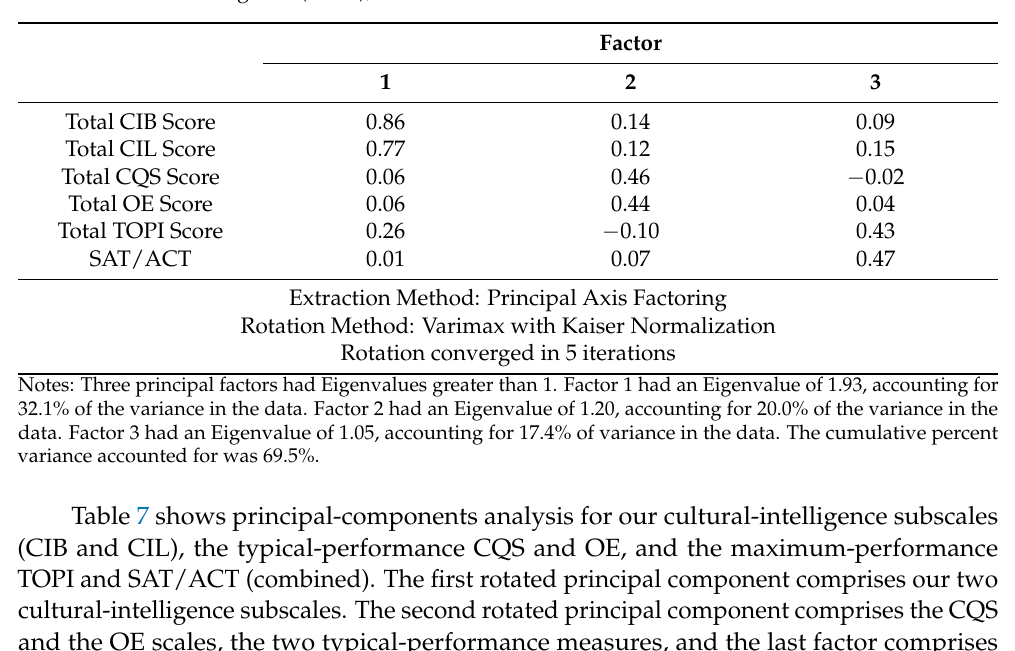
Table 8. Rotated Principal—Factor Matrix: Cultural Intelligence Tests—Business (CIB), Cultural Intelligence Tests—Business (CIL), Cultural Intelligence Scale (CQS), Openness to Experience (OE), Test of Personal Intelligence (TOPI), and SAT to ACT conversion